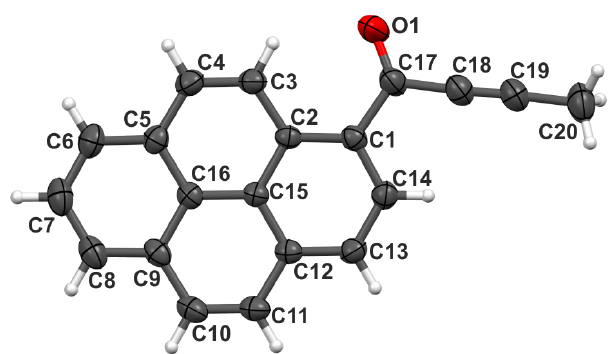
Figure 1. The molecule of compound 1a at ambient pressure and room temperature. Atomic displacement parameters represented at the 50% probability level. Hydrogen atom numbers are the same as the numbers of connected C